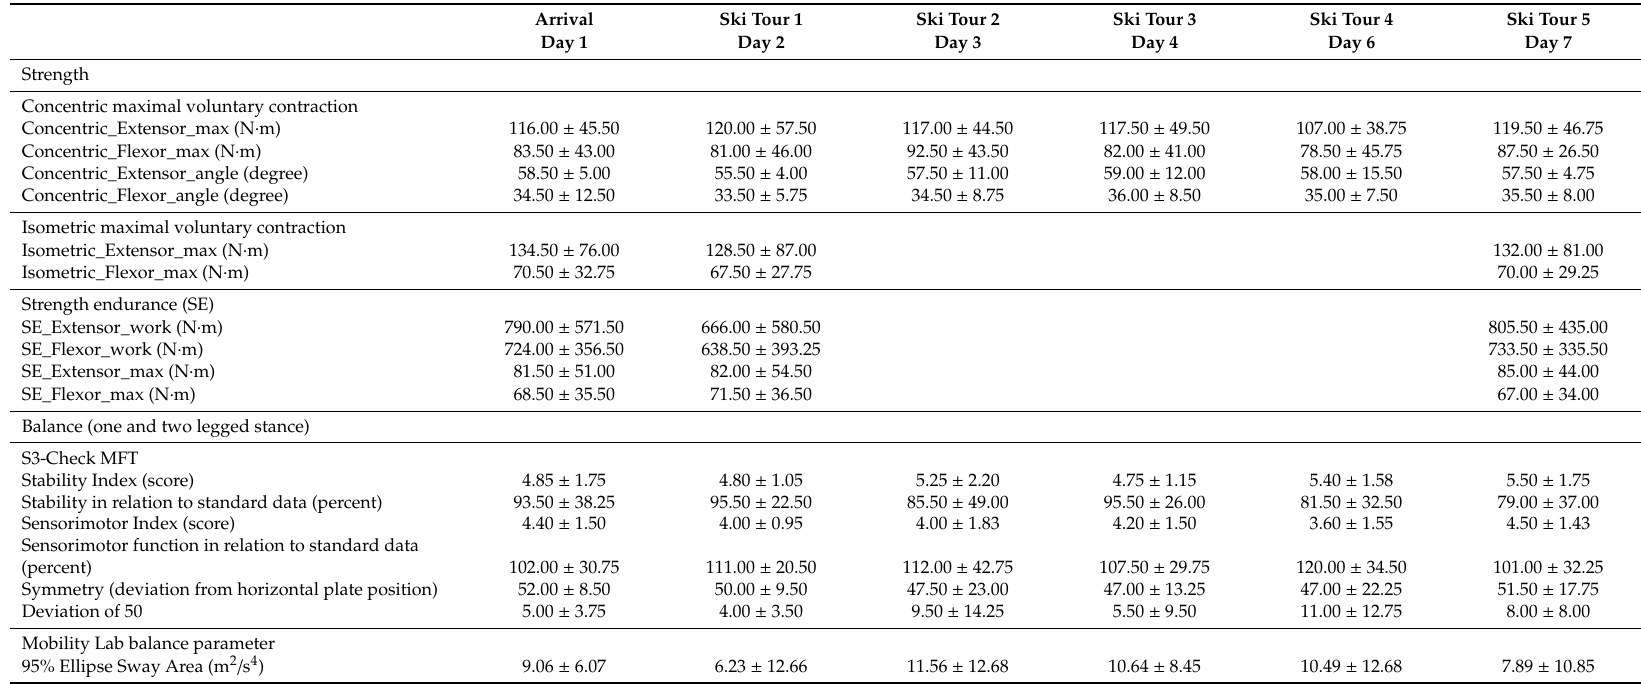
Table A1. Descriptive Data of Strength and